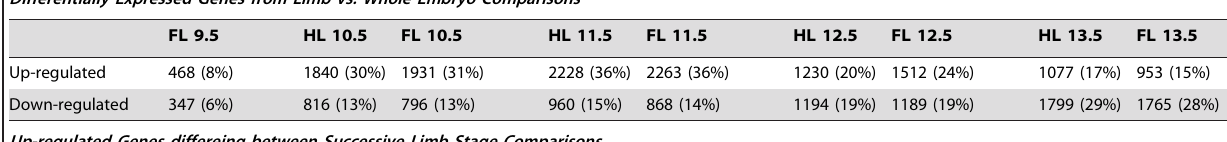
Table 1. Differentially Expressed